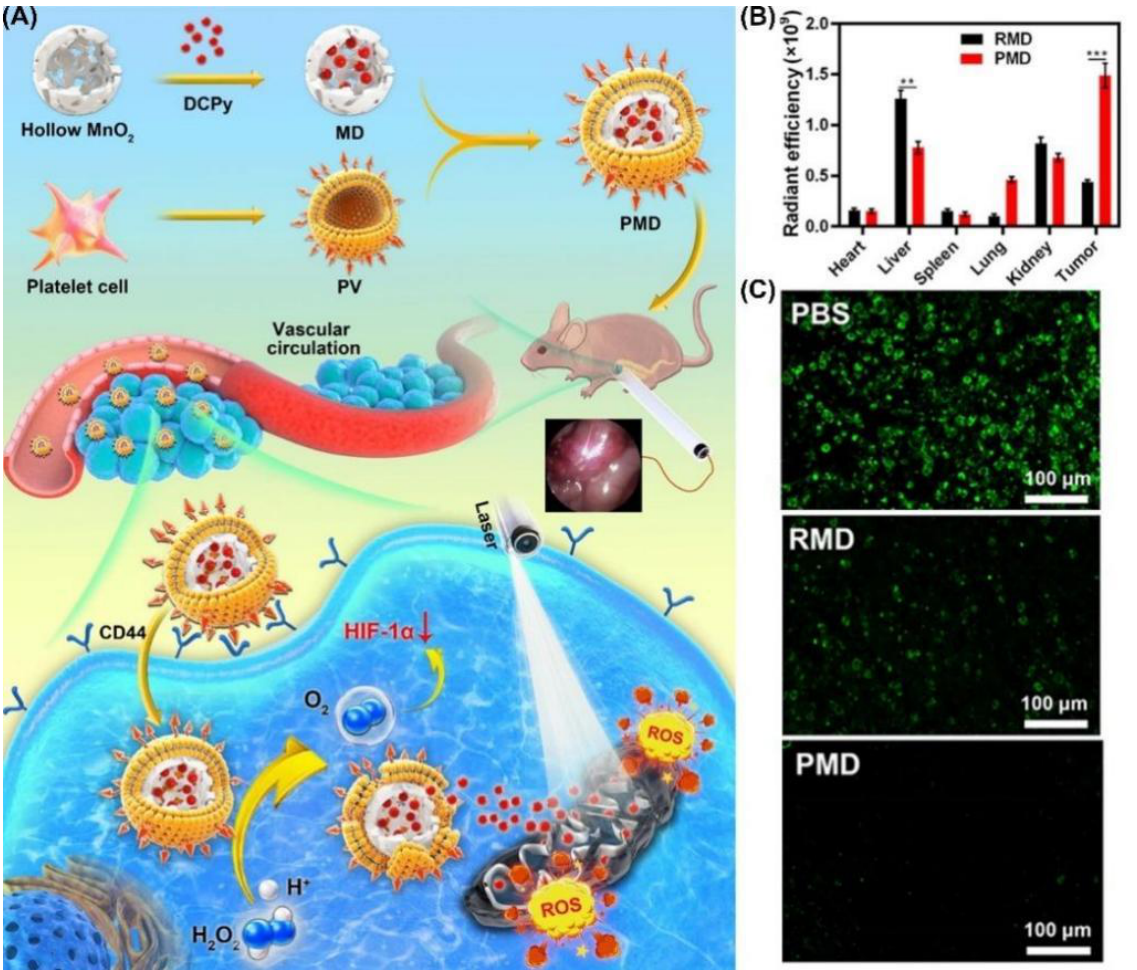
Figure 28. ( A ) Schematic illustration of the use of DCPy and PV as bionic nanozymes for photody- namic therapy; ( B ) radiant efficiency in tumors and different organs after PMD or RMD injection; ( C ) fluorescent staining for HIF-1 α (representing intratumoral hypoxia). ** p < 0.01, *** p < 0.001. Reprinted with permission from Ref. [188]. Copyright 2022 American Chemical Society.